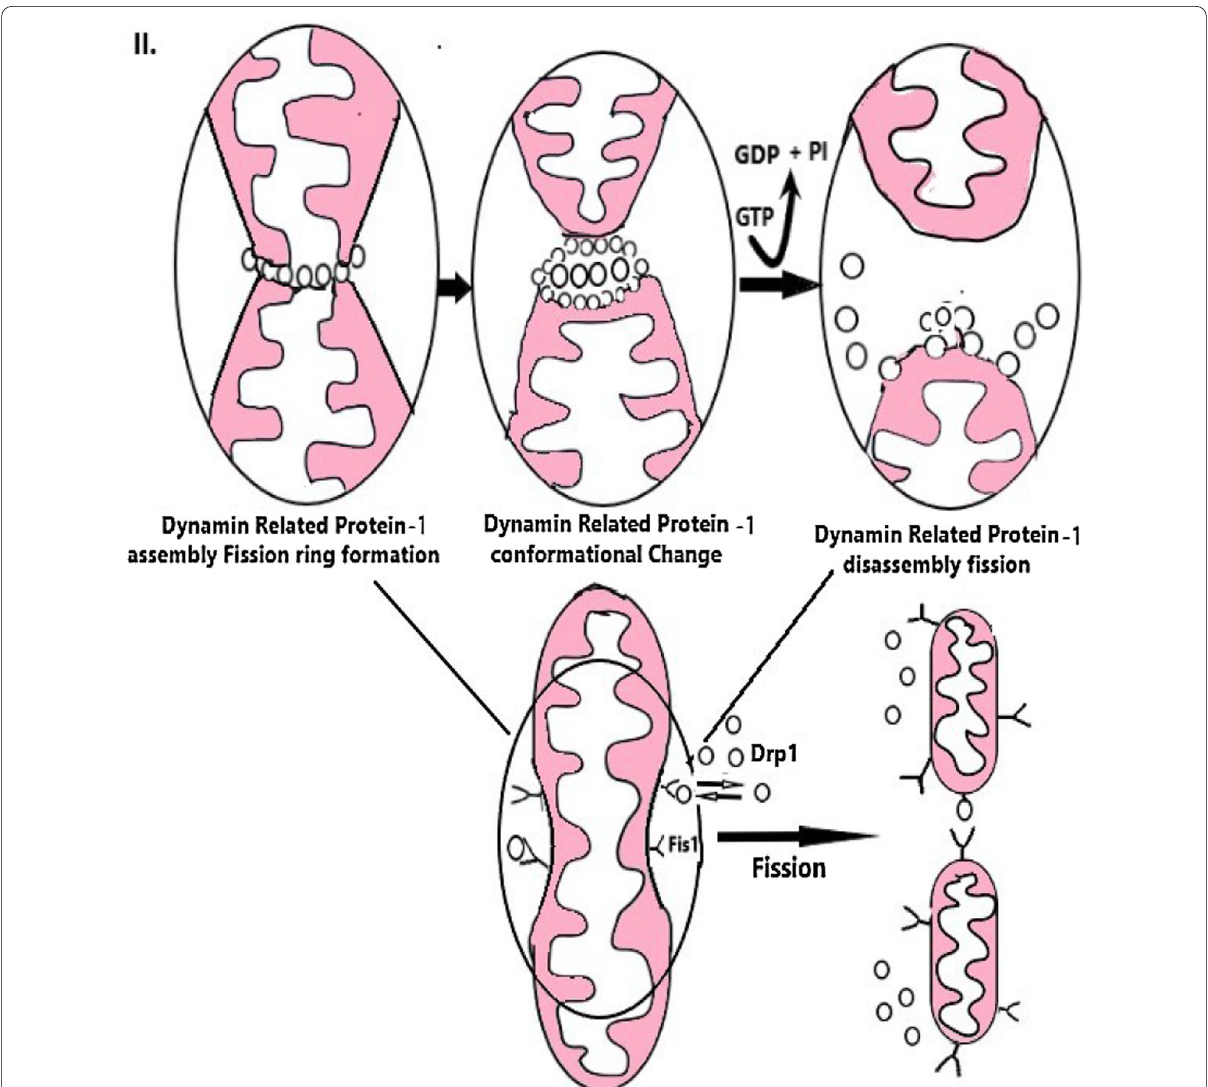
Fig. 6 Mitochondrial fission demonstrating the stretching of a single mitochondrion giving rise to two physically distinct mitochondria. GTP: Guanosine-5 ′ -triphosphate; GDP: Guanosine diphosphate; PI: Inorganic phosphate; Drp 1: dynamin-related protein 1; Fis 1: Mitochondrial fission 1